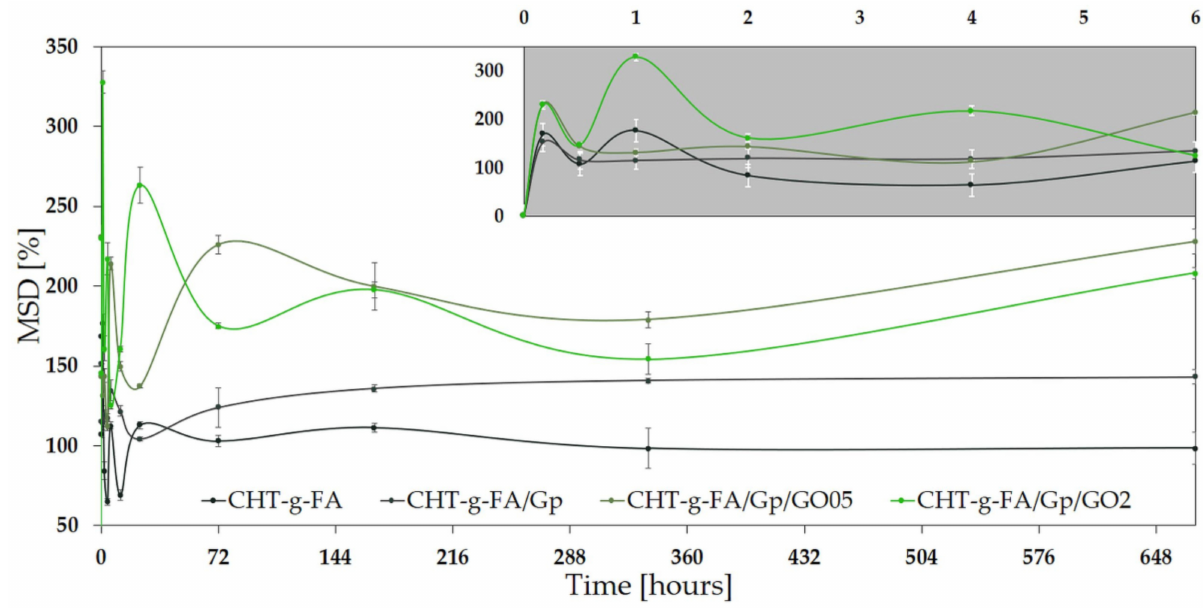
Figure 7. Maximum swelling degree achieved up to 672 h immersion in PBS. The inserts depict the variation from 0 to 6